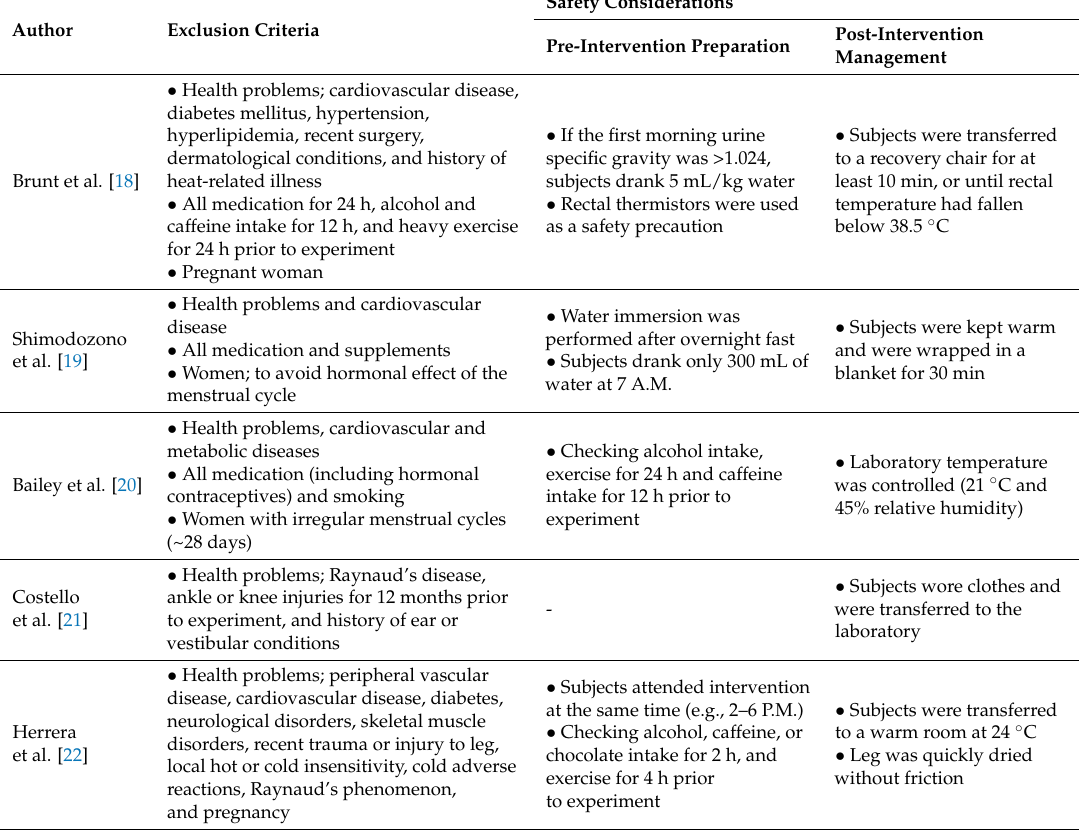
Table 1. Exclusion criteria and safety considerations in the included